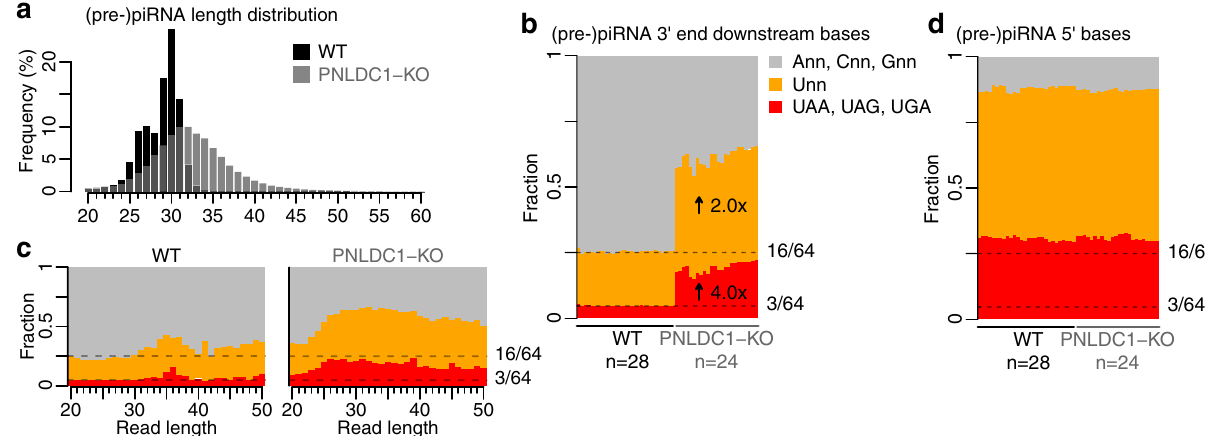
Fig. 3 Stop codons are enriched immediately downstream of pachytene pre-piRNA 3 ′ ends. a Length distribution of PNLDC1 knockout (KO) and wild- type (WT) controls. Individual conditions shown in Supplementary Fig. 4. b 1U and stop codon fraction immediately downstream of 3 ′ ends in wild-type (WT) and PNLDC1 knockout (KO) sRNA-seq libraries. Arrows indicate mean enrichment in KO relative to WT. Dashed lines indicate expected fraction assuming all trinucleotide sequences are equally abundant. c Bar graph showing mean fraction in ( b ) separated per read length across all WT (left) or PNLDC1-KO (right) sRNA-seq libraries. Individual conditions shown in Supplementary Fig. 4. d 1U and stop codon fraction at the (pre-)piRNA 5 ′ ends in wild-type (WT) and PNLDC1-KO sRNA-seq libraries. Dashed lines indicate expected fraction assuming all trinucleotide sequences are equally abundant. Source data are provided as a Source Data fi